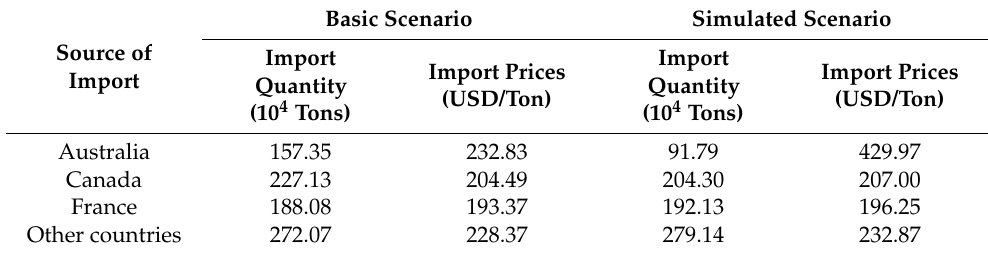
Table 9. Simulation results of changes in China’s barley import trade (Scenario